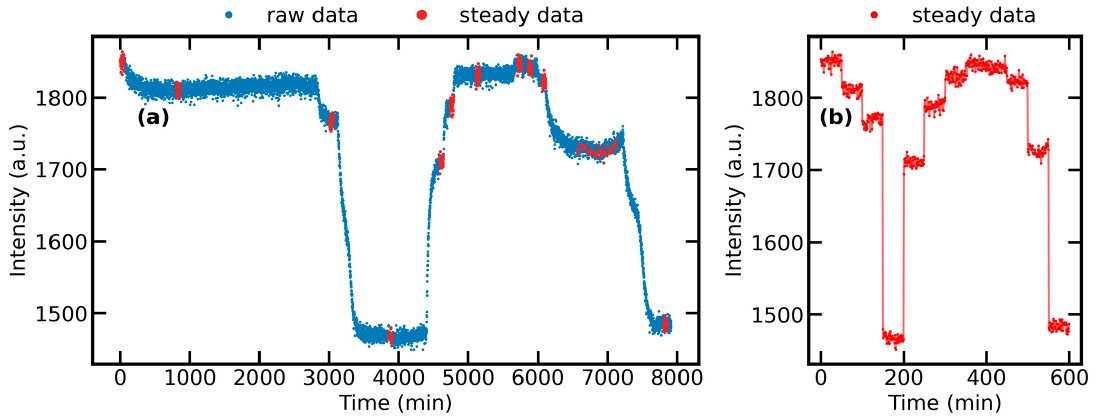
Figure A1. ( a ) Raw reflected light intensities for different RH between 75% and 100%, achieved by integrating between the wavelengths of 388 and 400 nm ( b ) chosen stable points for analysis. Raw data from the reflected light intensity used for the characterization of cement paste through sorption isotherm, as seen in Figure 6, is presented in Figure A2.